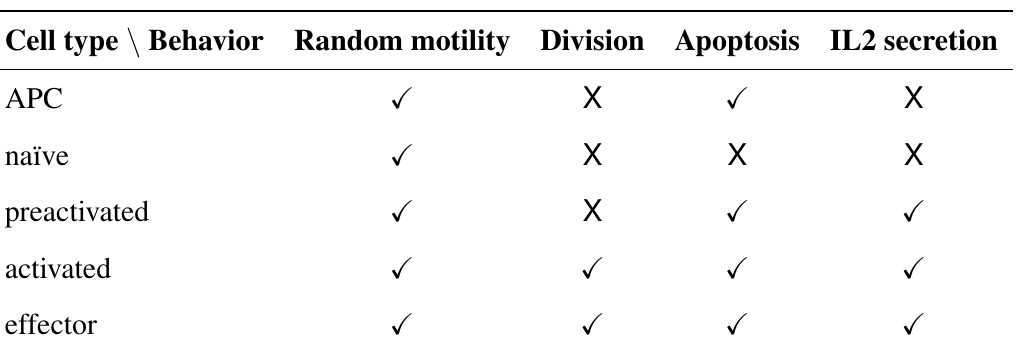
Table 2. Behaviors of the APC and T cell